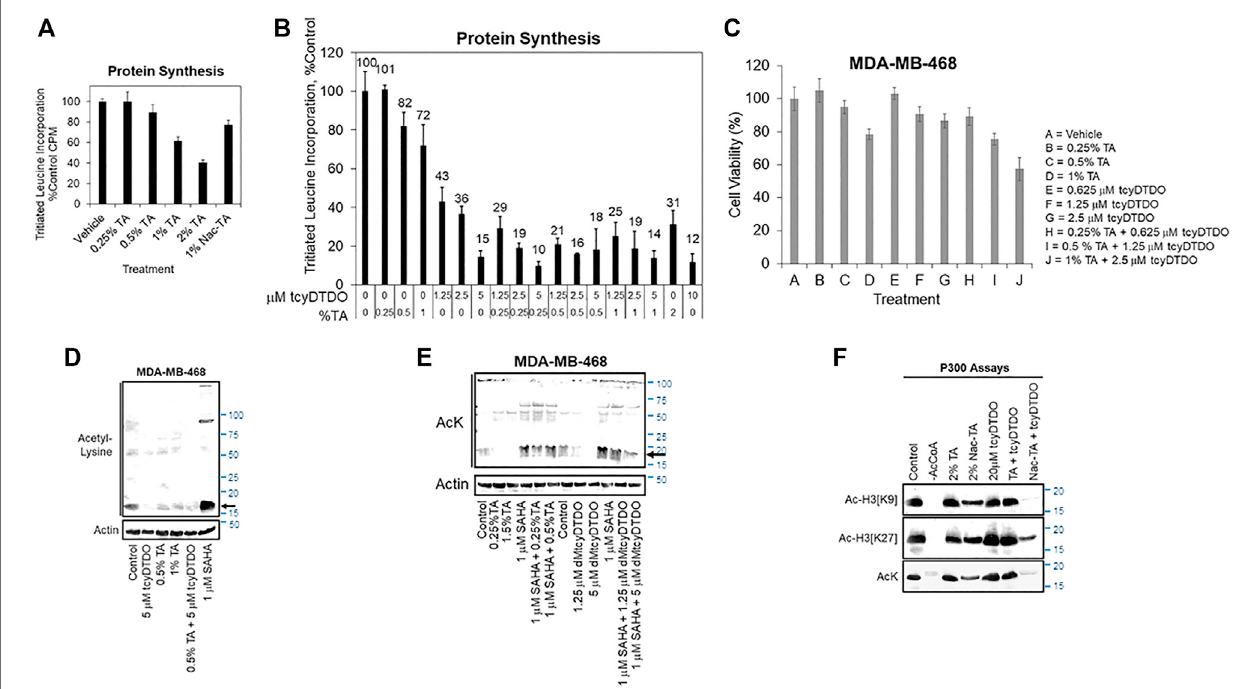
FIGURE 3 | TA and DDAs exhibit partially overlapping anticancer mechanisms that include inhibition of protein synthesis, cell viability, and Histone acetylation. (A) Proteinsynthesis assay, performed asin Supplementary Figure S1C , examiningthe effects of24 htreatmentswithvaryingTAconcentrations,or the N -acetylatedTA metabolite, NacTA, on protein synthesis in MDA-MB-468 cells. Results are the average of six replicates and presented as the average ± S.D. These fi ndings are representative of three biological replicates with similar results. (B) MDA-MB-468 cells were treated for 24 h with the indicated concentrations of tcyDTDO and TA and protein synthesis assays were performed. Results are the average of six replicates and presented as the average ± S.D. These fi ndings are representative of three biological replicates with similar results. (C) MTT cell viability assays performed after 72 h of the indicated treatments. Results are the average of six replicates and presented as the average ± S.D. These fi ndings are representative of three biological replicates with similar results. (D) MDA-MB-468 cells were treated for 24 h as indicated and cell extracts were analyzed by immunoblot with antibodies recognizing acetyl-Lys (AcK) and Actin as a loading control. SAHA, also referred to as Vorinostat, is a Histone Deacetylase (HDAC) inhibitor. (E) MDA-MB-468 cells were treated for 24 h as indicated and cell extracts were analyzed by immunoblot with antibodies recognizing acetyl-Lys (AcK) and Actin as a loading control. The black arrow indicates the band corresponding to acetylated histones. (F) In vitro acetyltransferaseassaysemployingp300astheacetyltransferaseandHistone3asthesubstrate.Assayswereperformedfor60 minat37 ° Cwiththeindicatedadditions and reaction mixtures wereanalyzed byimmunoblotwiththeindicatedantibodies recognizingacetyl-LysorHistone3speci fi cally acetylatedon Lysresidues 9or27.No acetylation was observed if Acetyl CoA was omitted from the